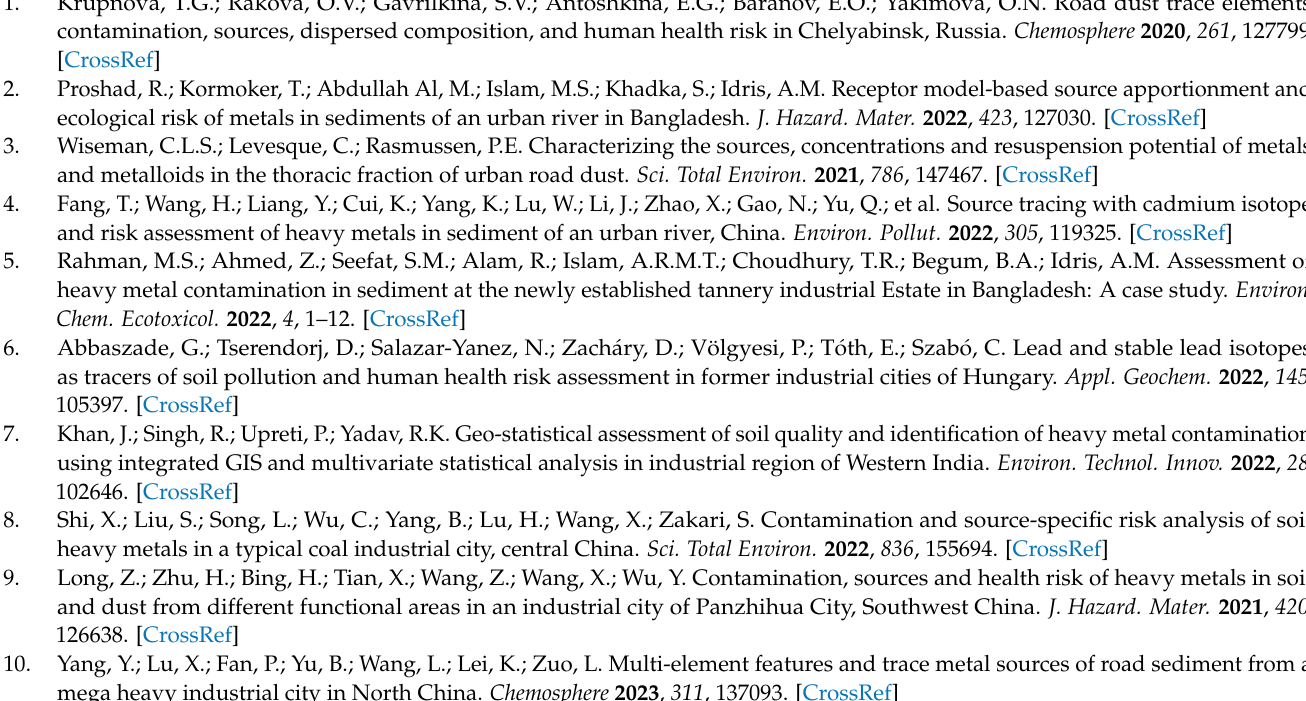
Calculation methods of ADD; Figure S1: Study area and sampling locations of the RSD in Shiji- azhuang; Figure S2: The assessment results of geo-accumulation index (Igeo) and Nemerow inte- grated geo-accumulation index (NIGI). (a) The Igeo values calculated based on the concentration of HMs in the RSD; (b) The NIGI of HMs in the RSD with MCS; Figure S3: Probabilistic cancer risk of specific sources for adult females. (a) Cumulative probability of TCR of specific sources; (b) The cancer risk of each carcinogenic HM from various sources; Figure S4: Probabilistic cancer risk of specific source for adult males. (a) Cumulative probability of TCR of specific sources; (b) The cancer risk of each carcinogenic HM from various sources; Figure S5: Probabilistic non-cancer risk of specific sources for adult females. (a) Cumulative probability of HI of specific sources; (b) The HQ of each HM from various sources; Figure S6: Probabilistic non-cancer risk of specific sources for adult males. (a) Cumulative probability of HI of specific sources; (b) The HQ of each HM from various sources; Table S1: Grades on the basis of Igeo, NIGI, Ei, and NCRI values; Table S2: Probability density functions of parameters and point value in health-risk-assessment (HRA) model with MCS; Table S3: Reference dose (RfD, mg (kg d) − 1 ) and slope factor (SF, (kg d) mg − 1 ) of